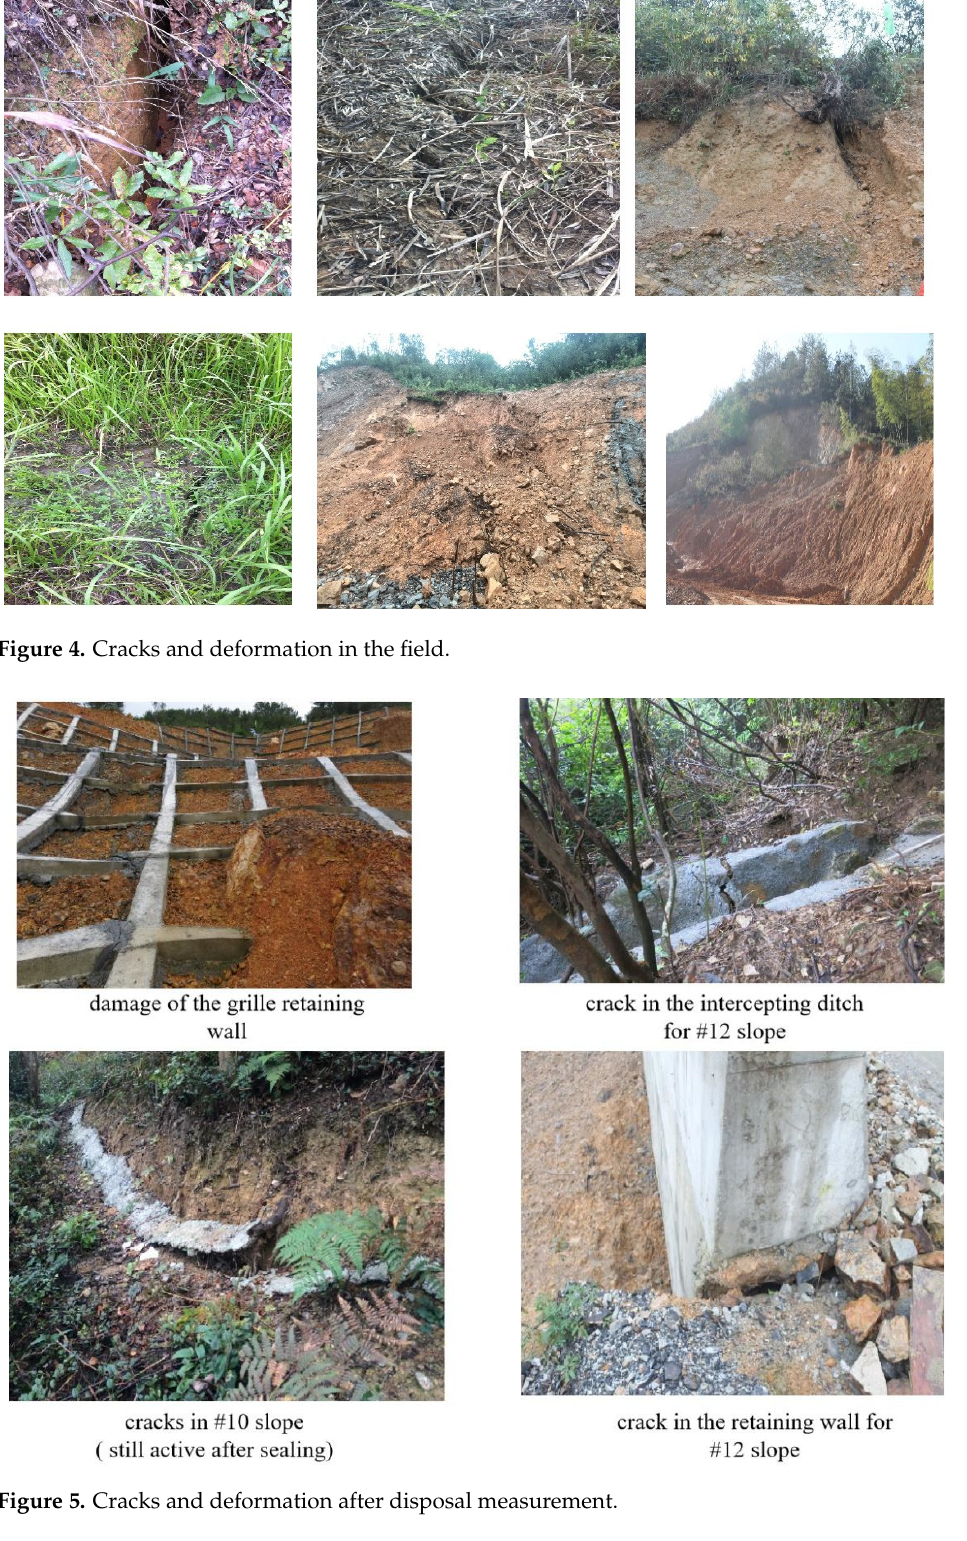
Figure 5. Cracks and deformation after disposal measurement.